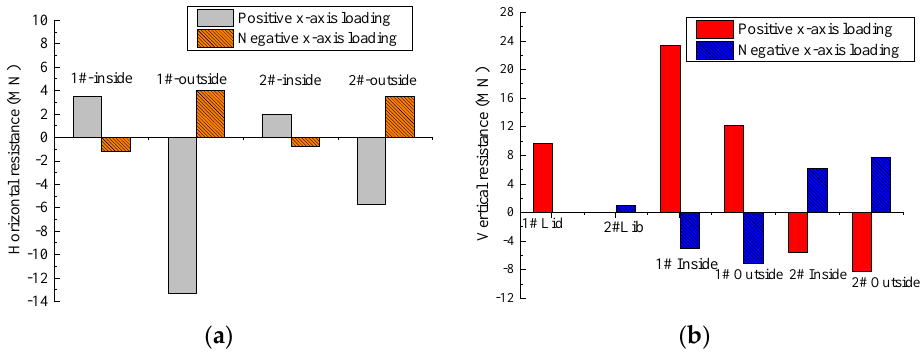
Figure 17. Horizontal and vertical resistance of each part of the buckets of TSPJF under ultimate horizontal load. ( a ) horizontal resistance, ( b ) vertical resistance.